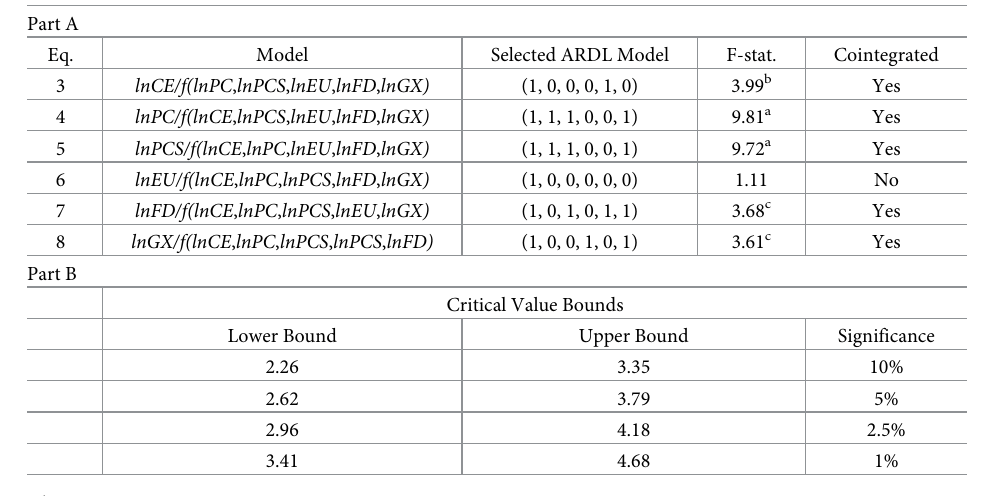
Table 2. Results of the ARDL bounds